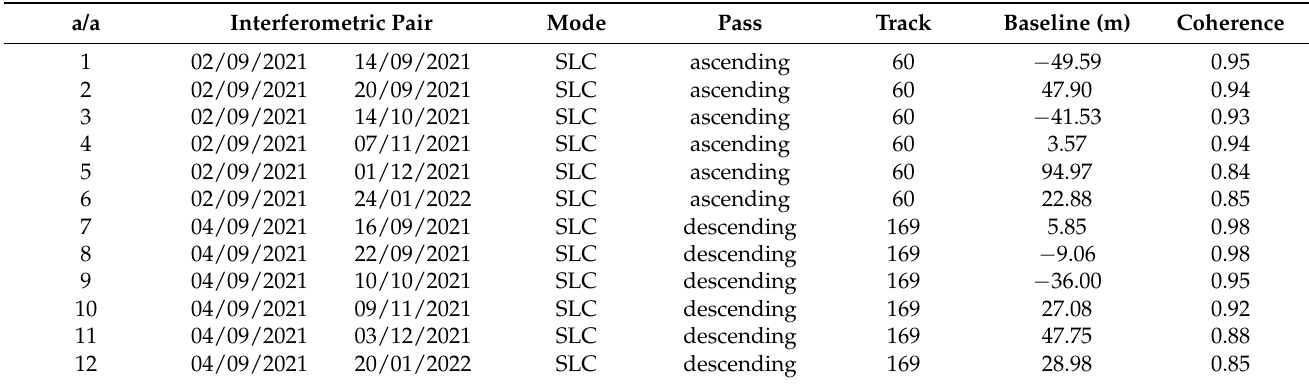
Table 2. Parameters of Sentinel-1 interferometric pairs (acquisition dates, product type, orbital path, baseline and coherence).